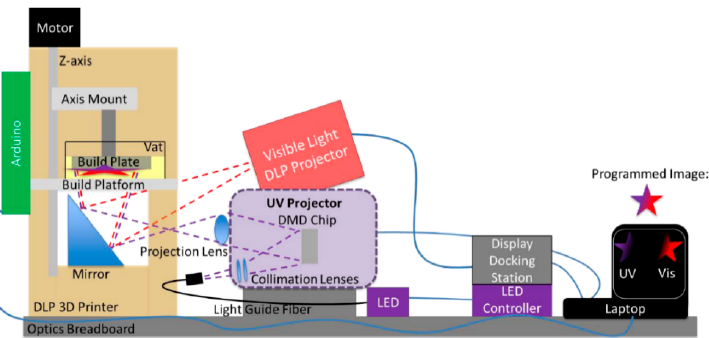
Figure 33. Customized multi-material DLP 3D printing setup with visible and UV projectors. Scan- ning process control was carried out using an integrated laptop. Reproduced from [320].